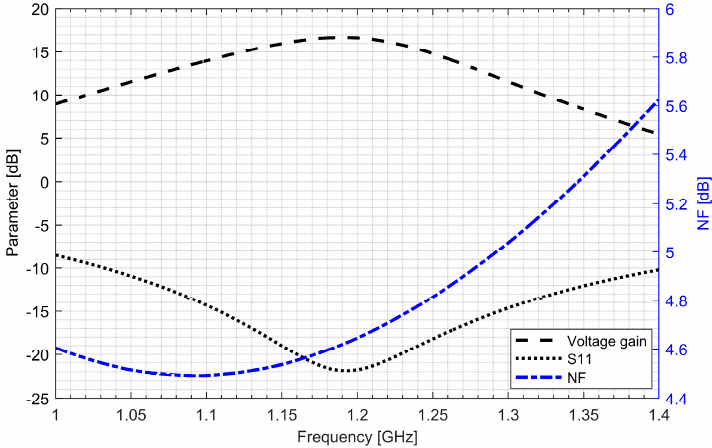
Figure 10. S11, voltage gain and noise figure characteristics of the L5/E5 band active balun.